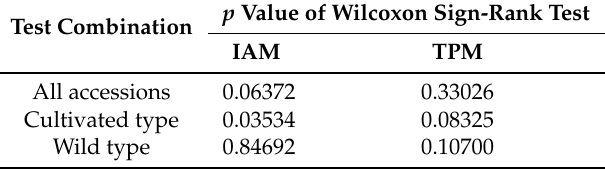
Table 4. Bottleneck effect of different